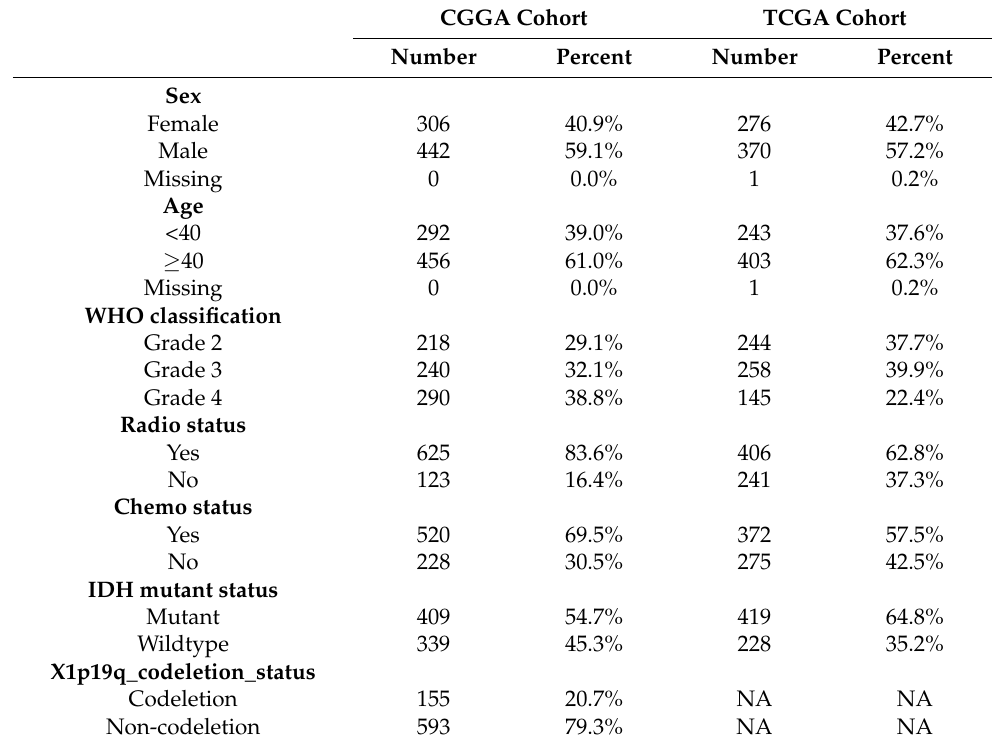
Table 1. Characteristics of patients in the CGGA cohort and TCGA